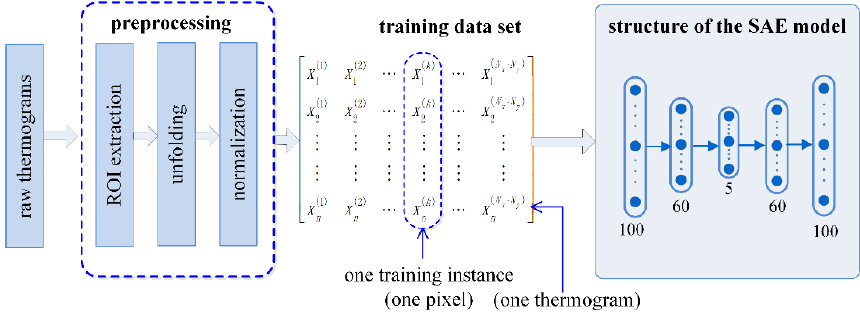
Figure 2. Training data set for the SAE model and the SAE structure used in this study.